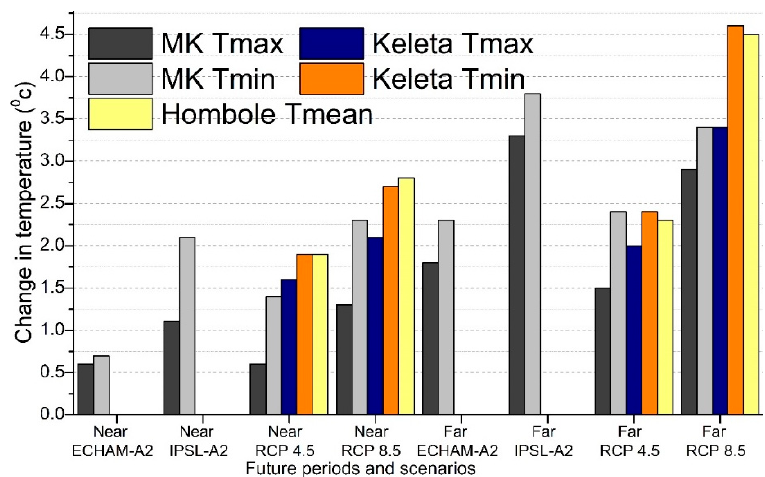
Figure 16. Comparison of projected changes in temperature (°C) in the MK, the Keleta and the Hombole subbasins.